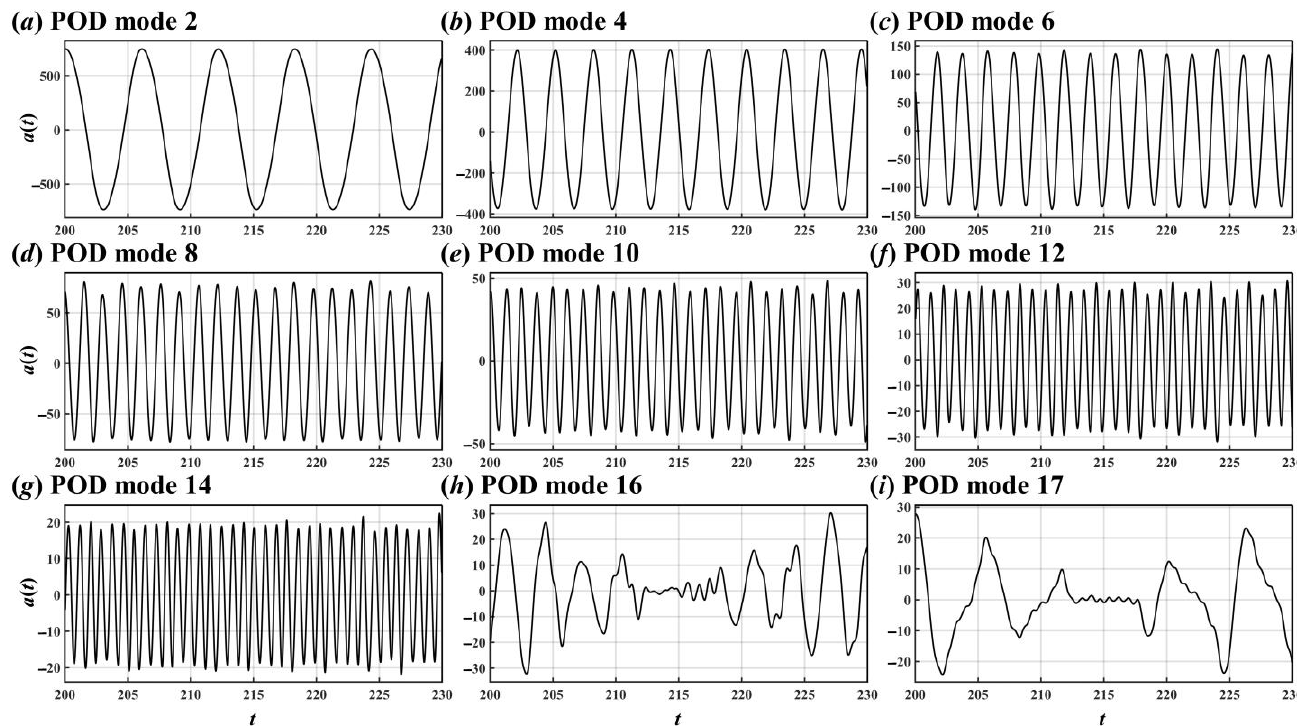
Figure 16. Time coefficients of the 2nd ( a ), 4th ( b ), 6th ( c ), 8th ( d ), 10th ( e ), 12th ( f ), 14th ( g ), 16th ( h ), and 17th ( i ) POD modes for the flow around the single cylinder.